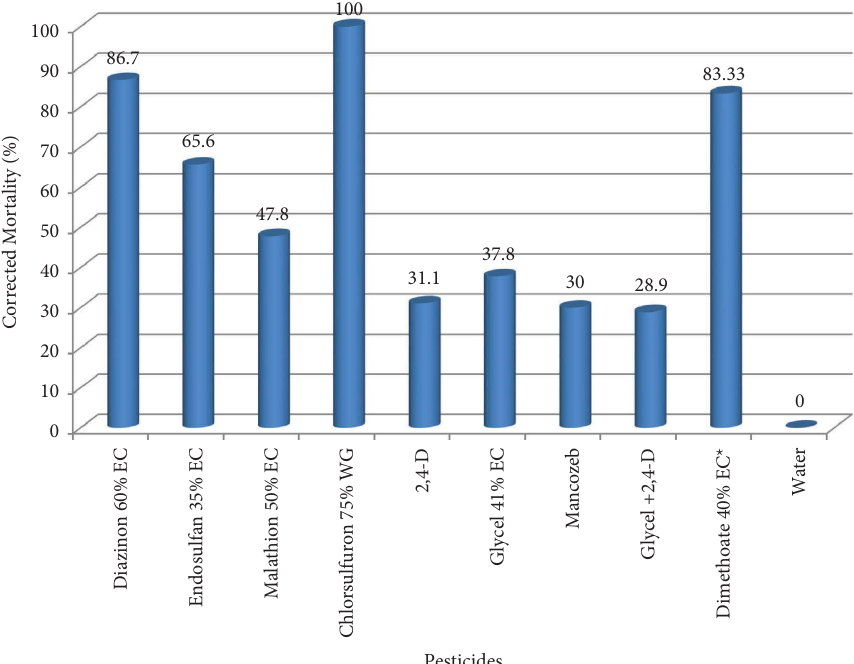
Figure 4: Mortality of local honeybees ( A. m. jemenitica ) when tested via